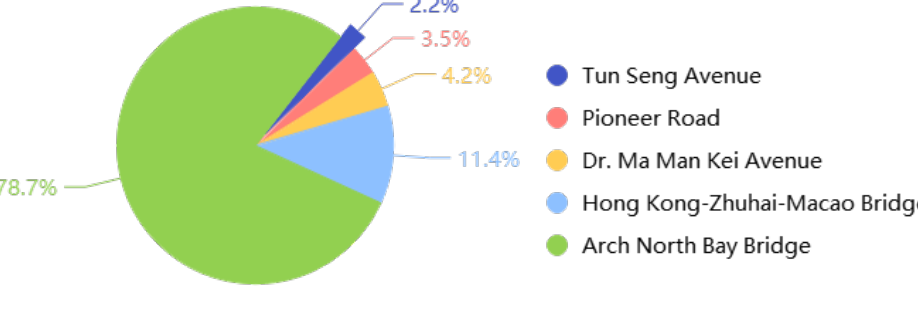
Figure 11. The change ratio of traffic expansion on the